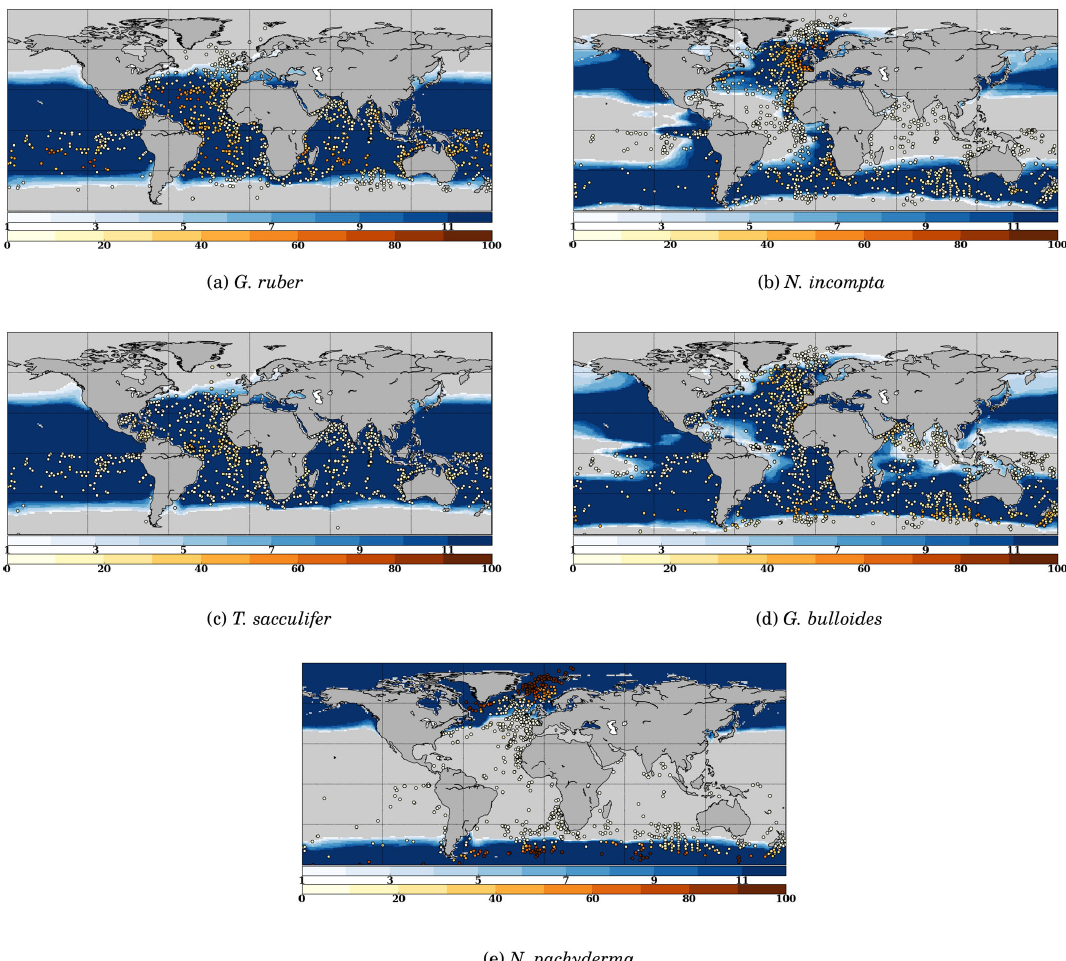
Figure B1. Model–data comparison of species’ abundances. Ocean regions where FAME predicts that the species is present at some time of the year ( µ (cid:48) > 0) are plotted in blue, with shades of blue indicating the number of months of presence. Overlaid are the MARGO Late Holocene data (all quality levels) species’ abundance data, plotted using the yellow–white to dark red color bar and given in percent. A qualitative correspondence between simulated FAME presence/absence and the occurrence of 10% level in the difference species is